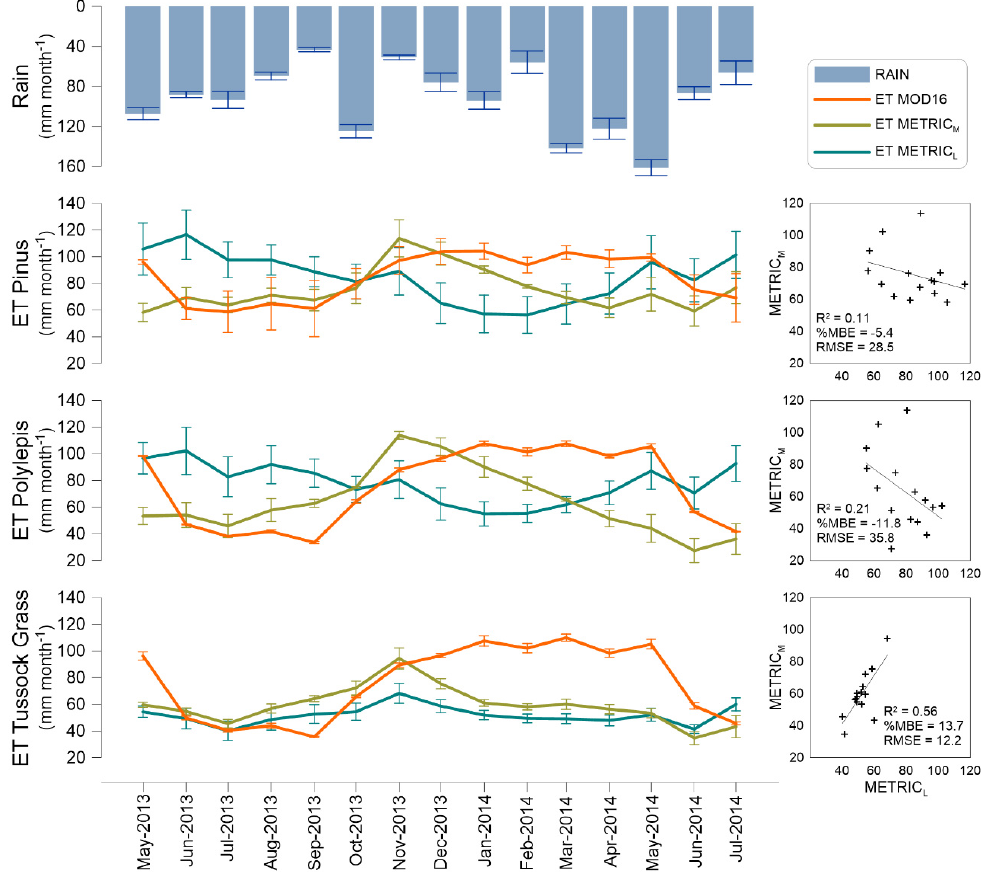
Figure 8. Monthly comparison of METRIC L , METRIC M , MOD16 ET in the testing plots. Statistical values of R 2 , mean bias error (MBE) and RMSE for the METRIC retrievals are shown, as well as the average rainfall from the AWSs. Error bars show SD.